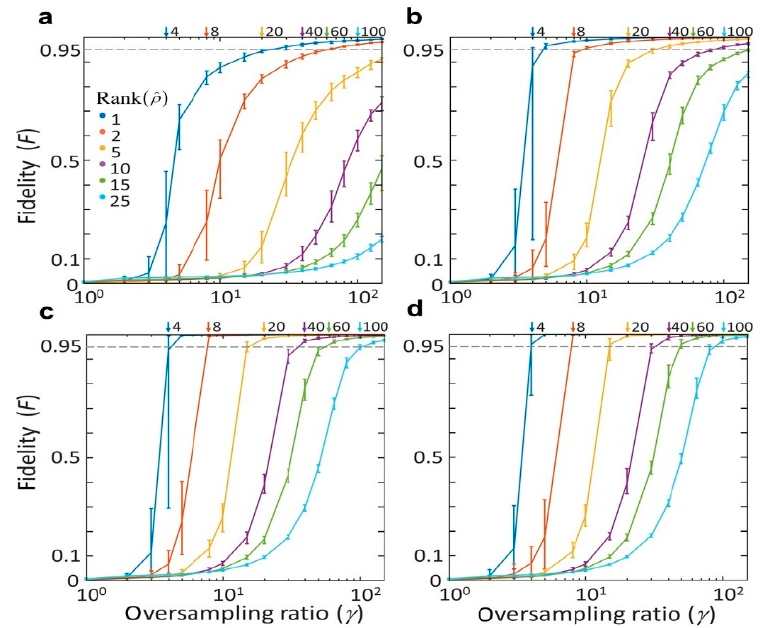
Figure 10. ( a – d ) The performance of the algorithm as a function of the rank of the SSM with SNR of 10 ( a ), 100 ( b ), 1000 ( c ), and infinity ( d ). The fidelity ( F ) is defined according to [92] and given by (cid:34) (cid:32)(cid:113) √ (cid:33)(cid:35) 2 F = Z 0 Z Z 0 tr , where Z 0 and Z represent the prepared and measured states, respectively. Adapted with permission from [67], APS.